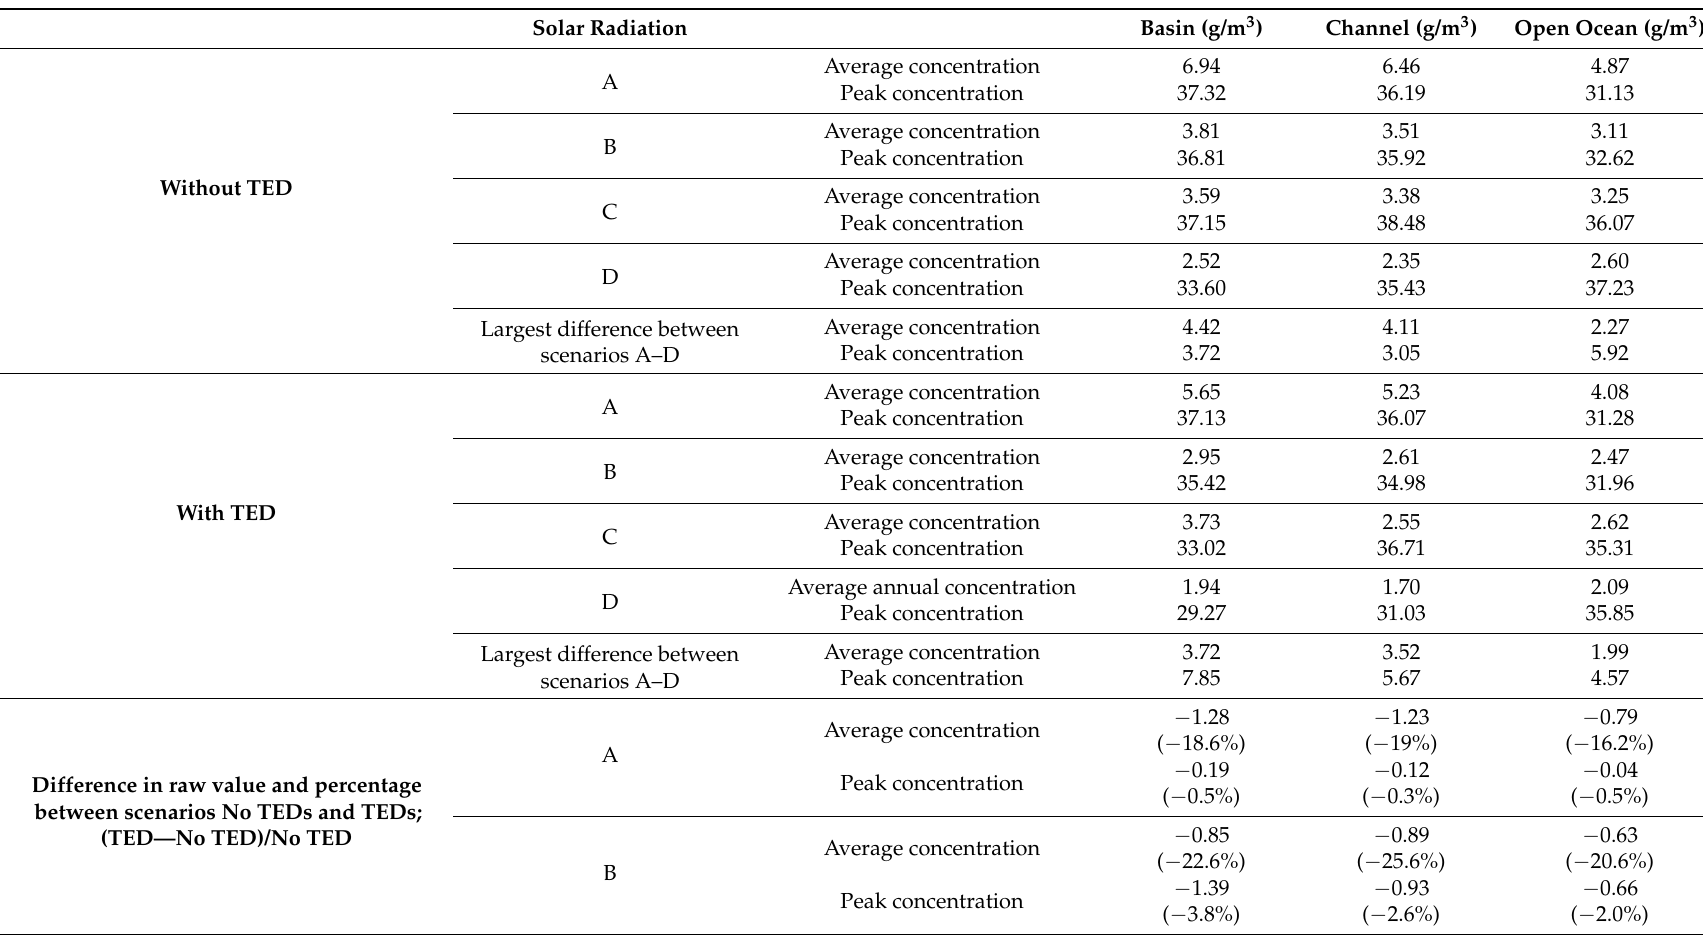
Table 3. Annual mean and peak phytoplankton concentrations for each scenario, averaged over the three locations: basin, channel, and open sea (Figure 1). Maximal differences between concentrations in PAR scenarios (as in Figure 4) and between TED